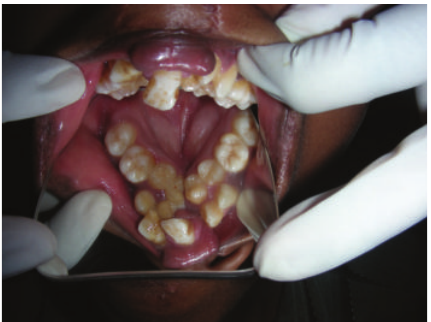
Figure 4: Collapsed high palatal arch.